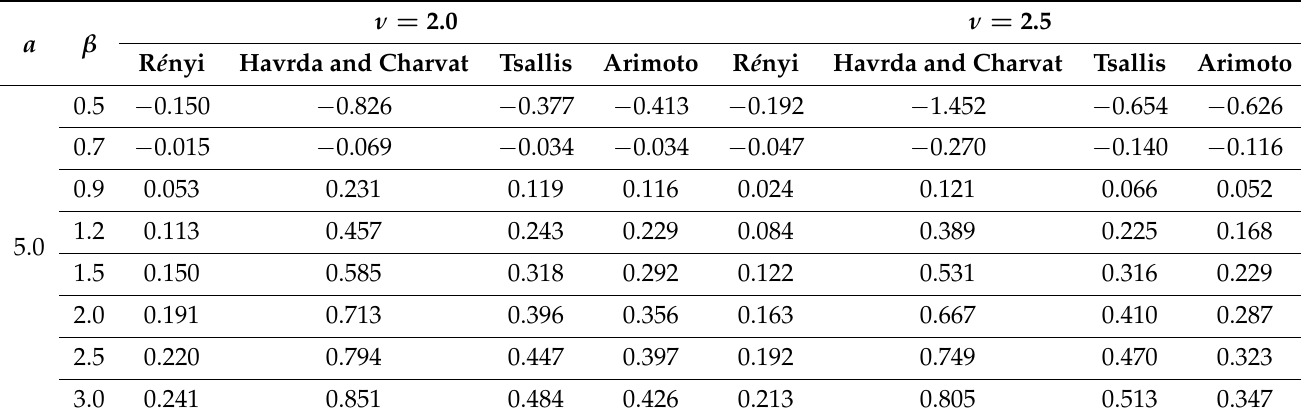
Table 3. Some numerical values of entropy at ν =